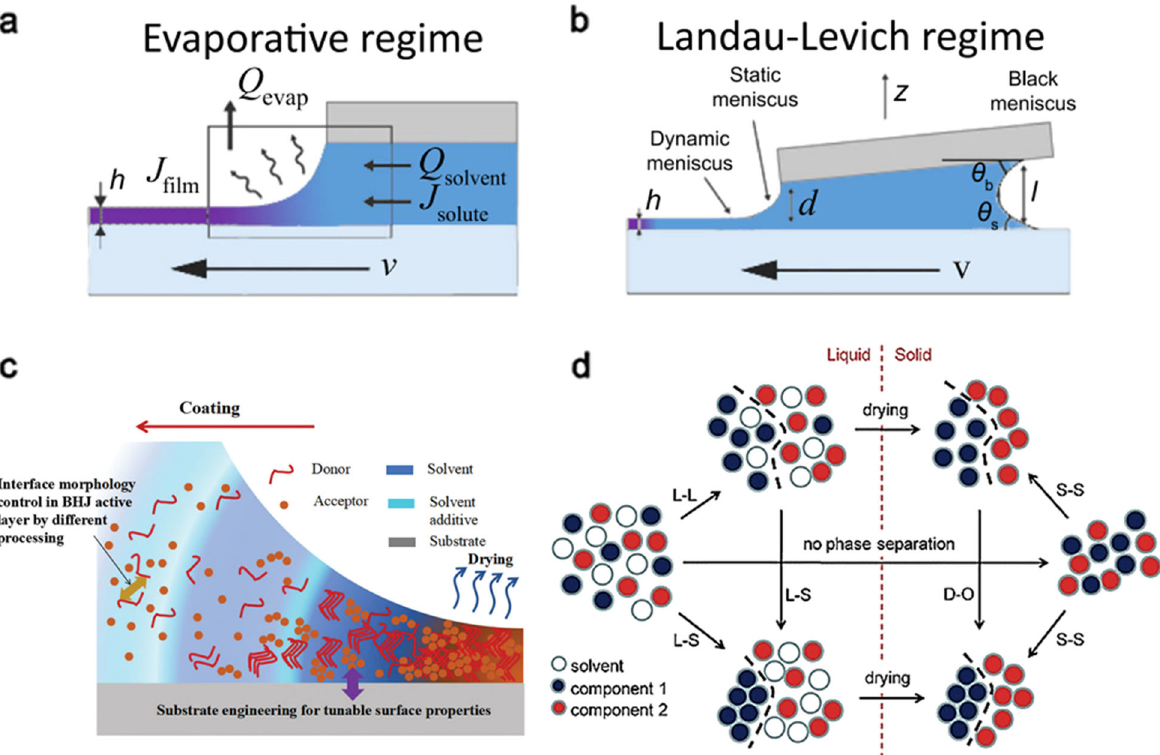
Fig. 5 Mechanism for the scalable coating organic photoactive layers. a , b Schematics of evaporation and Landau – Levich regimes of fi lm deposition 79 . c Schematic depiction of the possible routes to the formation of the BHJ morphology during deposition, which depends on the nature of the substrate and the evolution deposition conditions of the fi lm 82 . d Schematic exhibition of the phase separation processes that may occur during drying of a solution that contains two components. L – L, L – S, and S – S are liquid – liquid, liquid – solid, and solid – solid-phase separations, respectively, and D – O is disorder – order transition 81